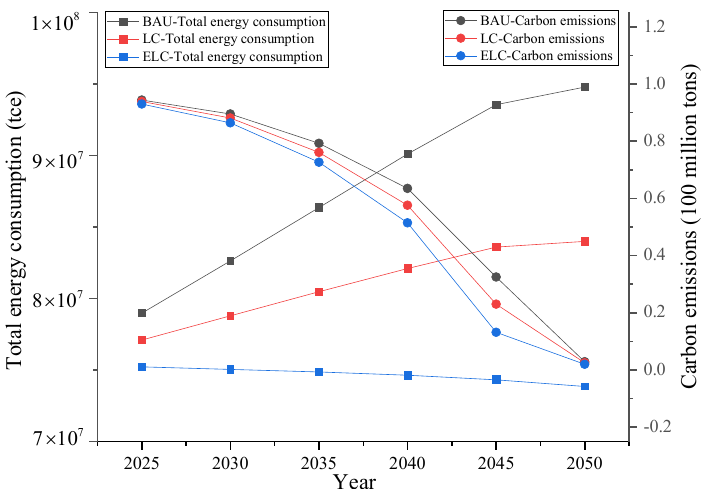
Figure 3. Change trends of total energy and carbon emissions under different scenarios.